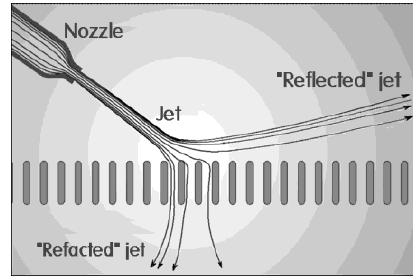
Fig. 12 Typical results of the numerical solution of the flow in the geometry from the previous Fig. 11. Shown in this picture are eight computed pathlines issuing from the nozzle.